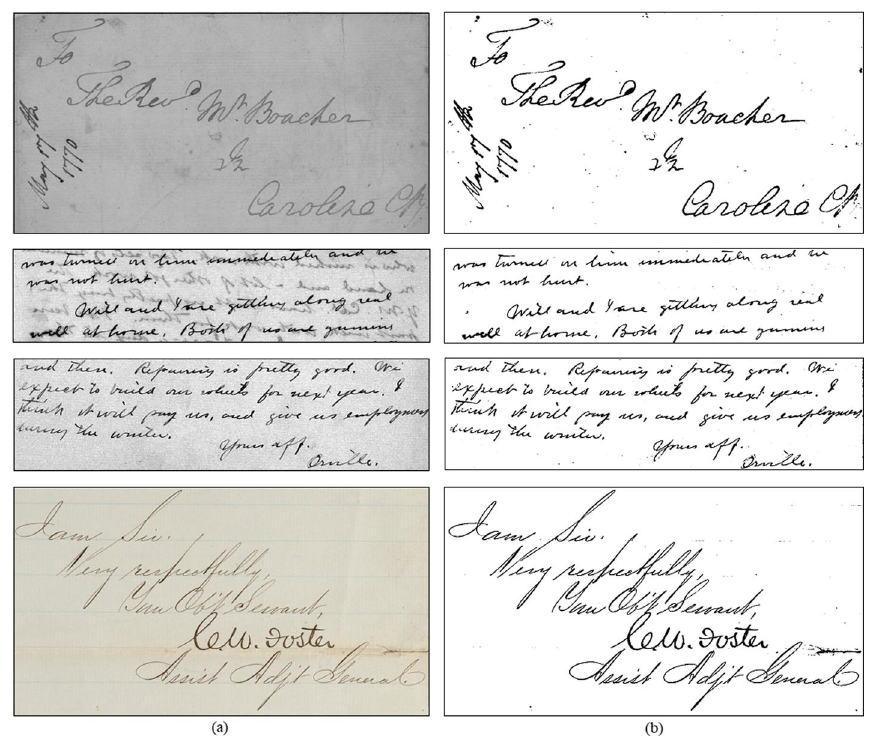
Fig. 2 Images binarization results from DIBCO 2010: a Original degraded images, b recovered text by the proposed non-local